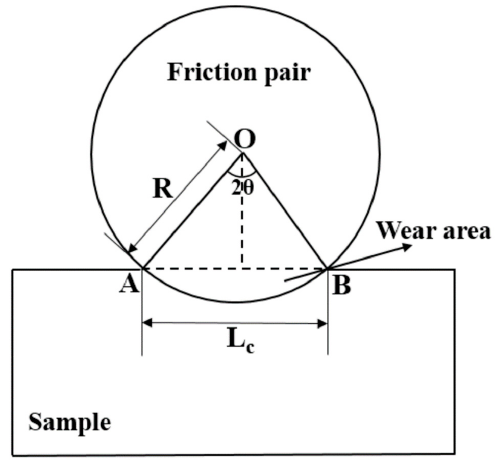
Figure 7. Calculation principle of the wear volume. Table 4. Wear data of the substrate and the AlCoCrFeNiNb x high-entropy alloy coatings. Sample Wear Cross Section (S) ( µ m 2 ) Wear Volume (V) (mm 3